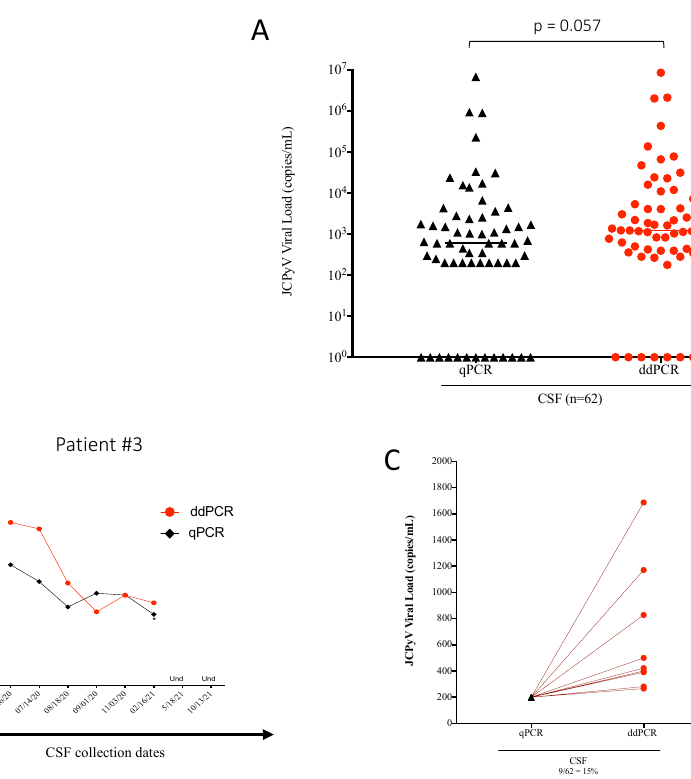
Figure 3. (A) Sixty-two JCPyV-DNA from CSF of PML patients at different time points amplified by qPCR and ddPCR show no significant difference between the two assays. (B) Representative plot comparing DNA samples extracted from CSF of a PML patient at 8 different collection dates and amplified by qPCR and ddPCR; * indicates limit of quantification for qPCR set at <250 copies/mL. The last two time points were undetected in both systems. (C) Representation of nine samples that were at the lower limit of quantification set at <250c/mL by qPCR, while an absolute quantification could be determined by ddPCR. (D) Representation of five samples that were only detected by ddPCR. Limit of quantification for ddPCR = 110-250 copies/mL.